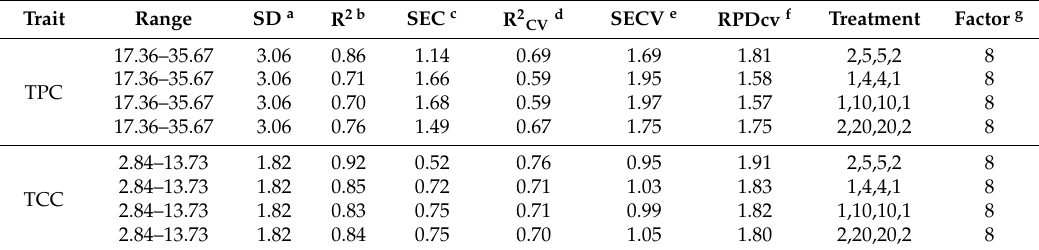
Table 1. Calibration and cross-validation statistics of total phenolic content (TPC expressed